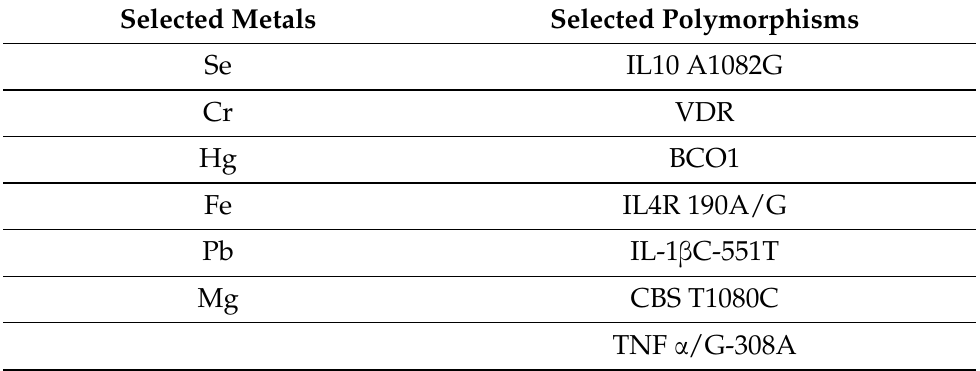
Table 4. List of the selected features. The feature are achieved by means of Boruta algorithm.